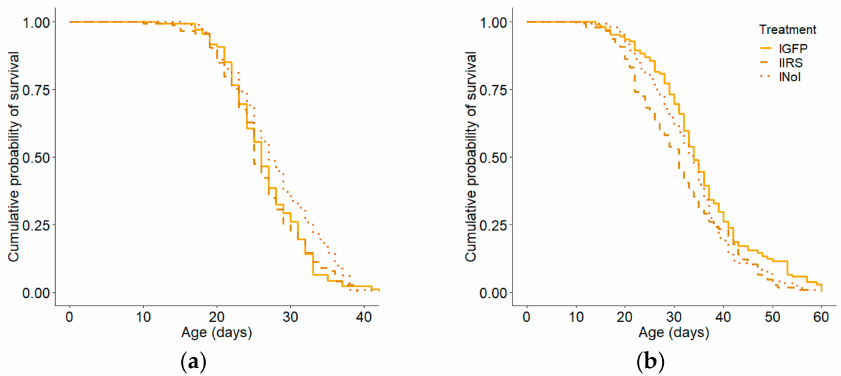
Figure 7. E ff ect of irs knockdown on total lifespan for the low pollen hoarding strain by host colony. In the low strain, the e ff ect of irs knockdown (lIRS) relative to GFP-injected control (lGFP) on total lifespan was not significant in ( a ) colony 1 (Kaplan–Meier: χ 2 = 5.9, p = 0.051, n = 446, Cox–Mantel: p = 0.054). ( b ) In colony 2 irs knockdown resulted in decreased total lifespan (Kaplan–Meier: χ 2 =